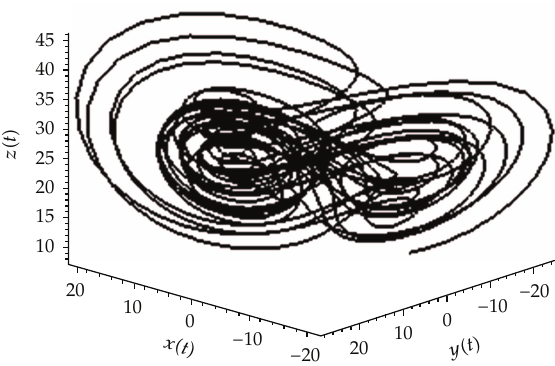
Figure 2: It shows the attractor of hyperchaotic L¨u dynamical system at a 1 (cid:8) 36 ,b 1 (cid:8) 3 ,c 1 (cid:8) 20, and d 1 (cid:8) 1 . 3 in x,y,z